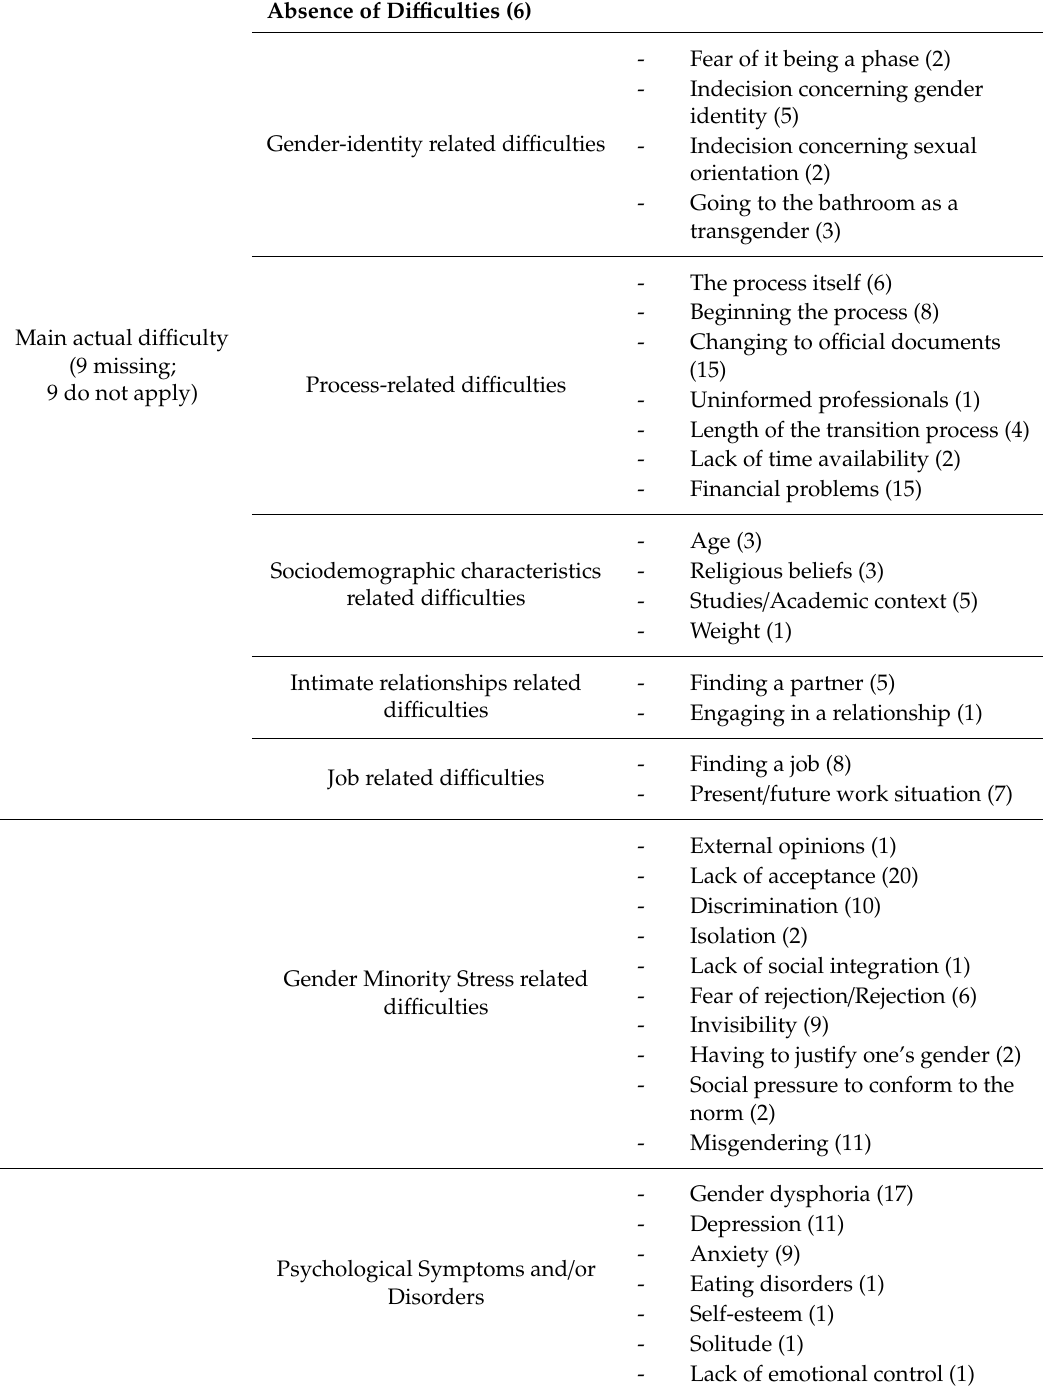
Table 3. Main themes and respective codes regarding the question “What is the main di ffi culty that you are facing